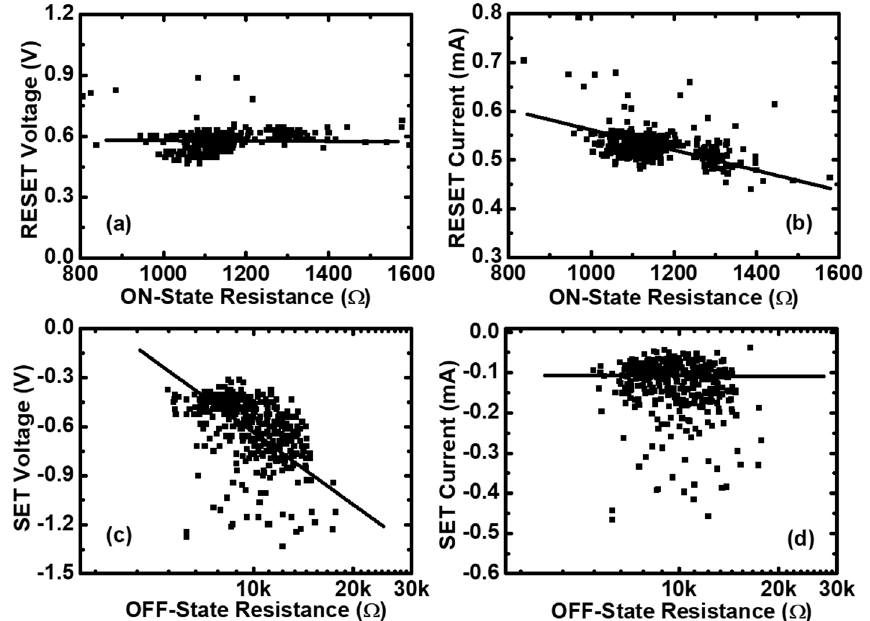
Figure 2. The statistics of resistance switching (RS) parameters in Pt / Pt:SiO x / Ta memristors. ( a ) The Reset voltages and ( b ) the Reset currents versus the ON-state resistances for the measured 400 cycling data of the same device. ( c ) The Set voltages and ( d ) the Set currents versus the OFF-state resistances for the measured 400 cycling data of the same device.